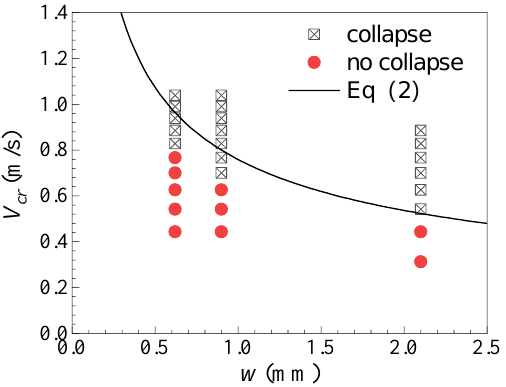
Figure 7. Critical velocity for the droplet collapsing on the superhydrophobic mesh changes as a function of the width of the mesh gap ( w ).